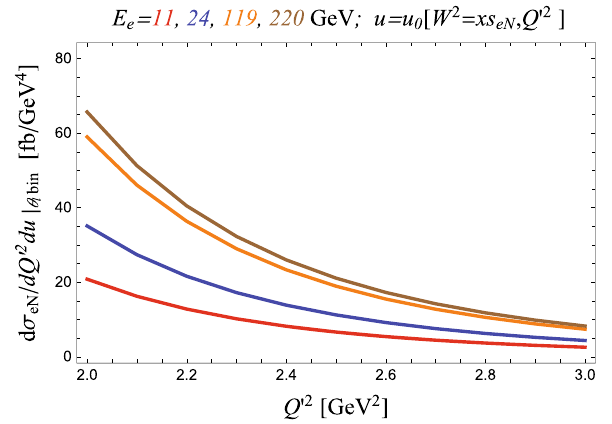
Fig. 9 The electron–nucleon cross section (47) integrated over θ (cid:6) as a function of Q (cid:4) 2 for u = u 0 (exactly backward TCS) at electron beam energies E e corresponding (from down to up) to kinematical conditions of JLab@12, JLab@24 and of EIC and EicC. We employ the VMD- based model for γ N TDAs and account for the contribution of ω( 782 ) meson. We use the set of G V , T ω couplings Bonn 2000 [31] and COZ NN solution for nucleon DAs as phenomenological